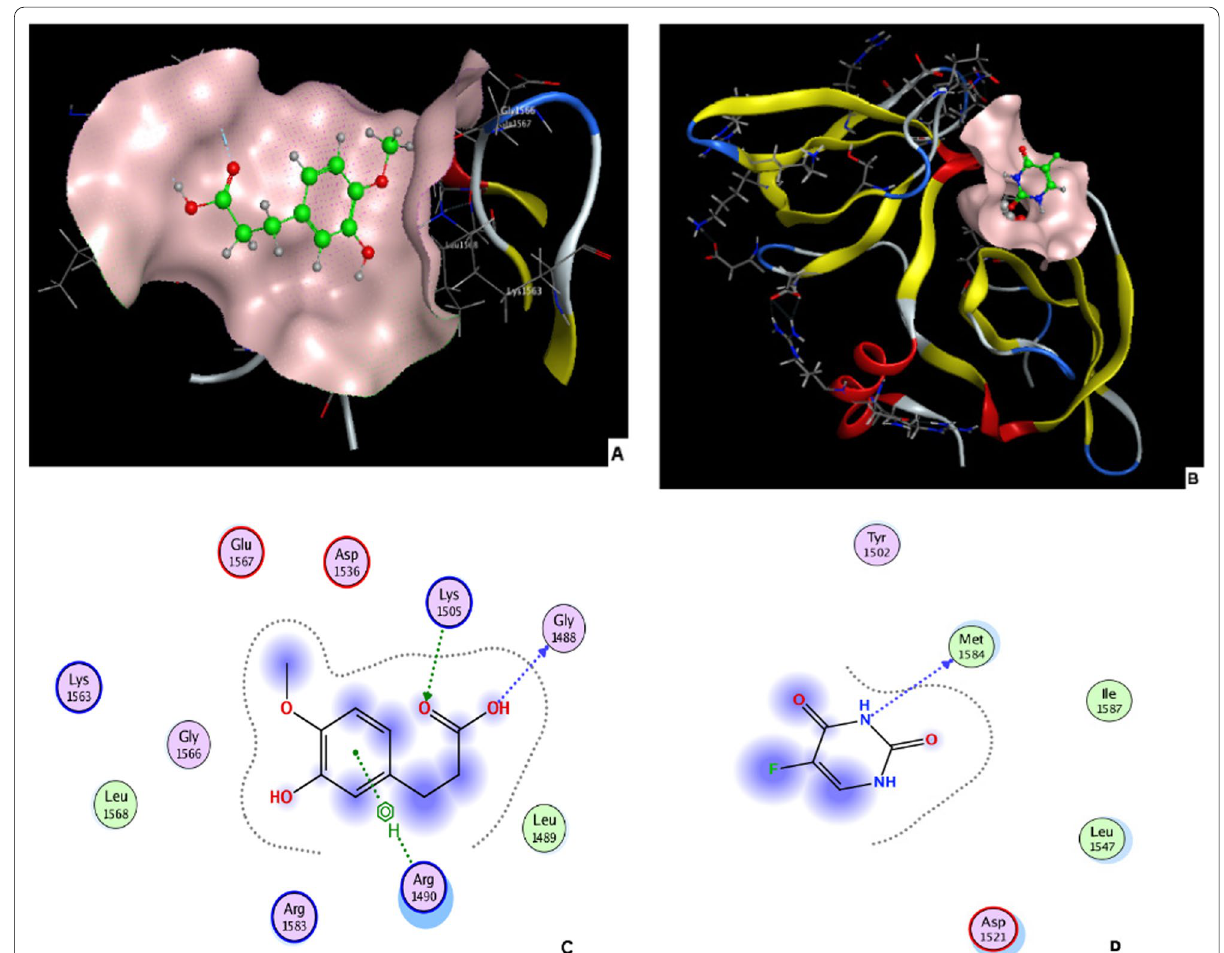
Fig. 1 Molecular docking of P53 (PDB: 6MXZ), A : 3D interaction diagram with FA, B : 3D interaction diagram with 5FU, C : 2D interaction diagram with 5FU, D : 2D interaction diagram with 5FU